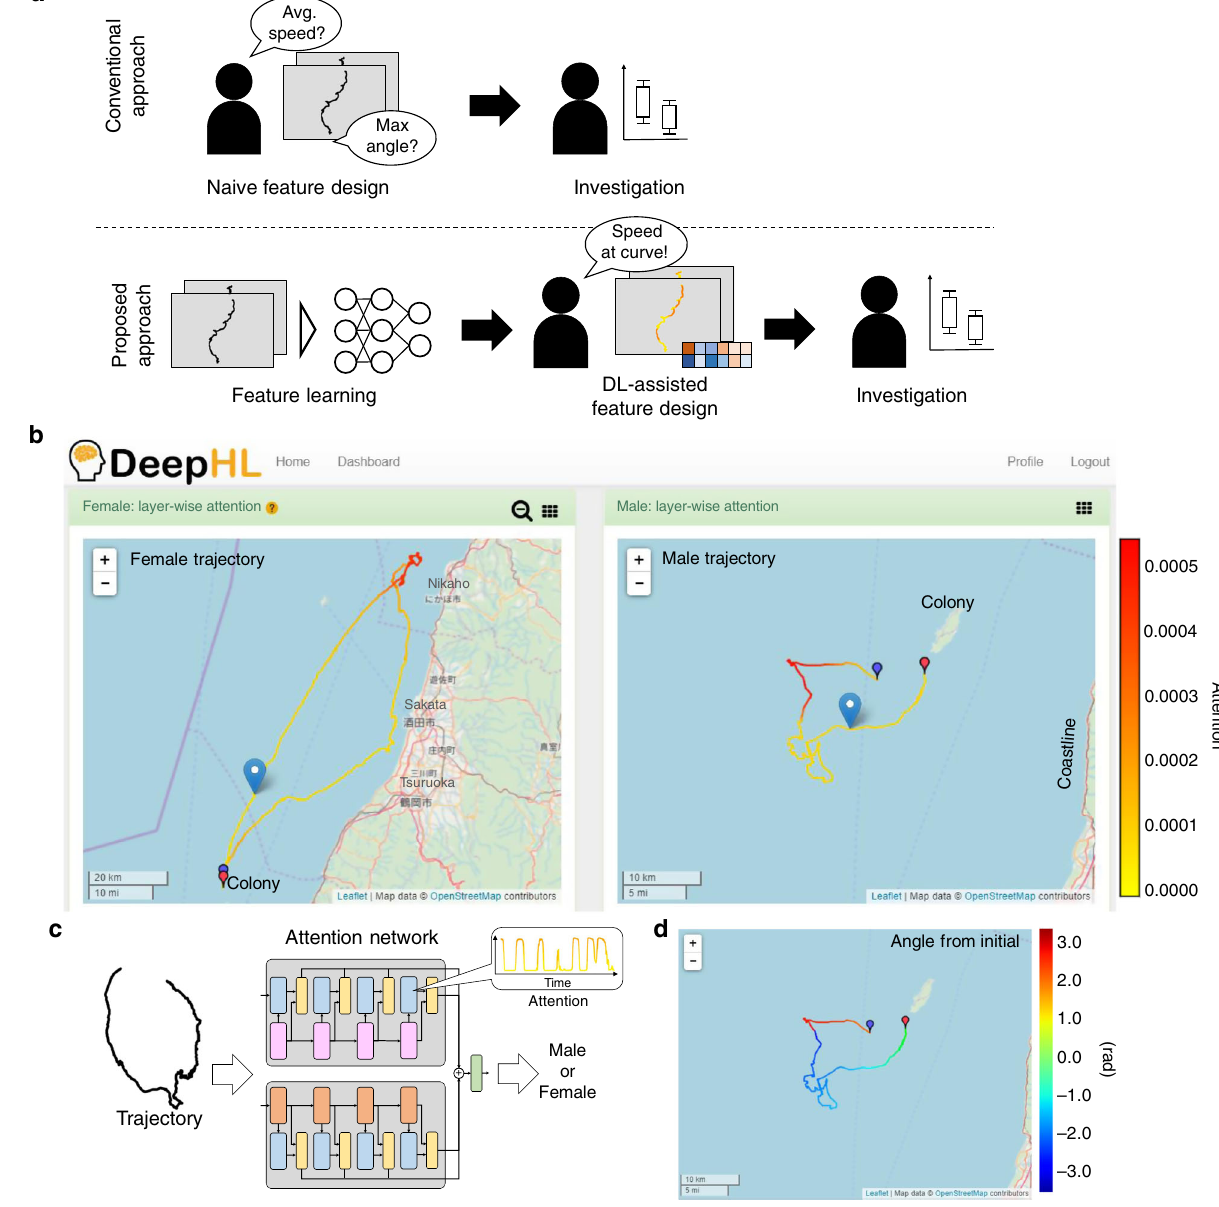
Fig. 1 Trajectory highlighting and analysis with DeepHL. a Difference in research procedures between the conventional and proposed deep learning (DL)- assisted approaches. b Screenshot of the DeepHL web interface comparing the trajectories of a female (left) and male (right) streaked shearwater. Some characteristic segments of the trajectories are highlighted in red; these were detected by our neural network model trained to distinguish between the trajectories of male and female birds. A user can observe that there is something worth investigating in the highlighted segments. In this case, the female trajectory is highlighted when the female bird stays close to the coastline (see Supplementary Information, Application to the study of seabirds, for more detailed analysis). In contrast, the male trajectory is highlighted when the male bird travels away from the coastline. Note that the small blue and red pins on the maps indicate the starting and terminating points of the trajectories, respectively. The large blue pin on the map moves along the trajectory at a speed proportional to the actual movement speed (Supplementary Movie 1). c DeepHL extracts the segments in an input trajectory to which the neural network pays attention when classifying the trajectory by using a time series of the attention values. These segments reveal the importance of each data point. The input trajectory is colored by the time series of the attention values. The range of colors used to color the trajectories is shown on the right of b . d To facilitate a deeper understanding of the implications of the highlighted segments, DeepHL colors trajectories with the values of other sensor data or handcrafted features highly correlated with the attention values; the angle between the vertical axis ( y axis) and a line segment connecting the initial position and each point is used in this example. Points with large angles are focused as shown in the red segments in the male bird trajectory of b .